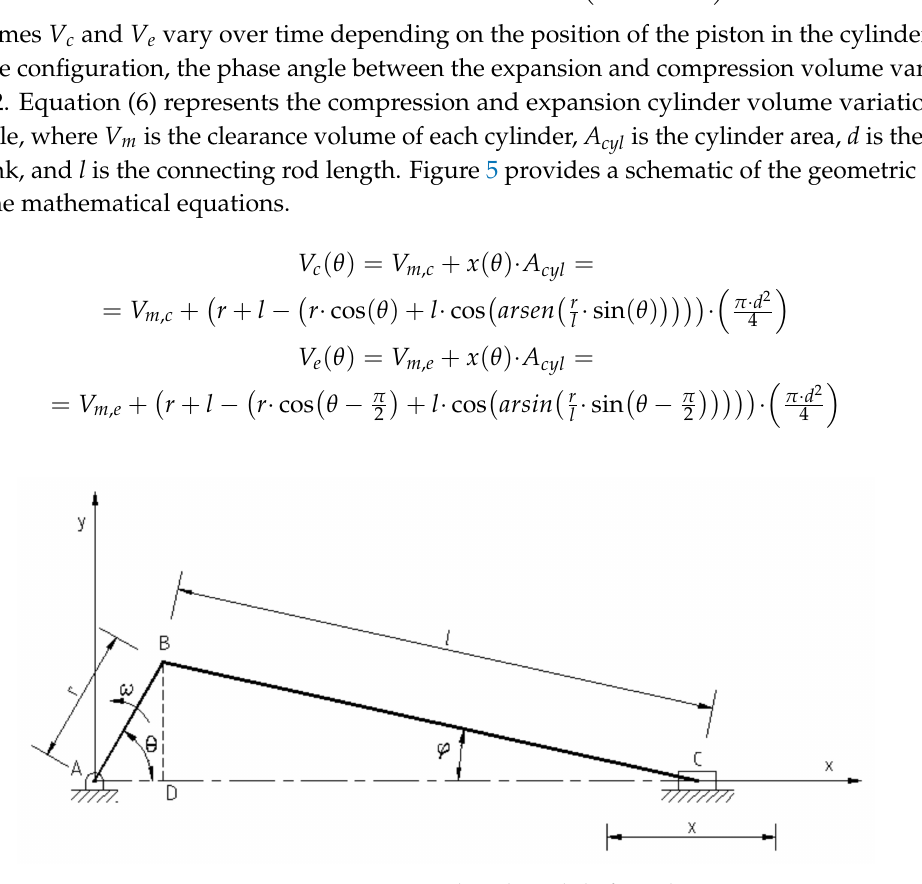
Figure 5. Piston, connecting rod, and crankshaft